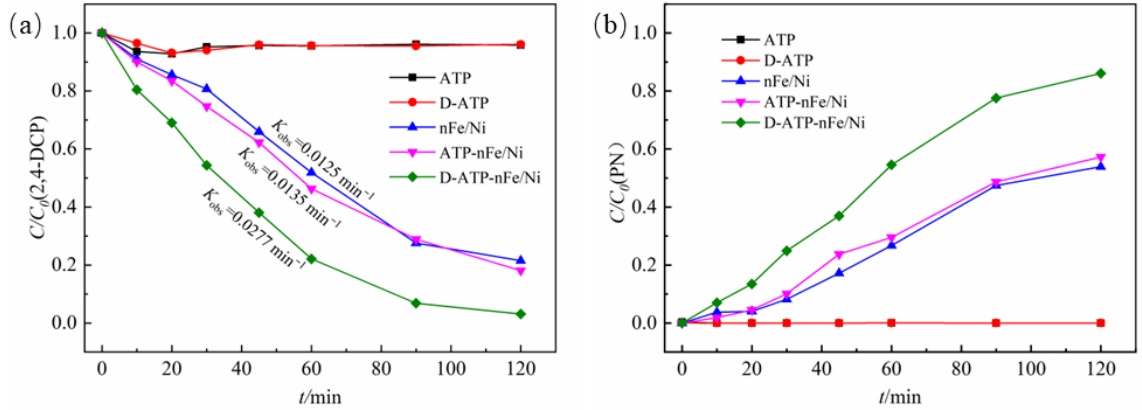
Figure 3. The concentration changes of ( a ) 2,4-DCP and ( b ) phenol.